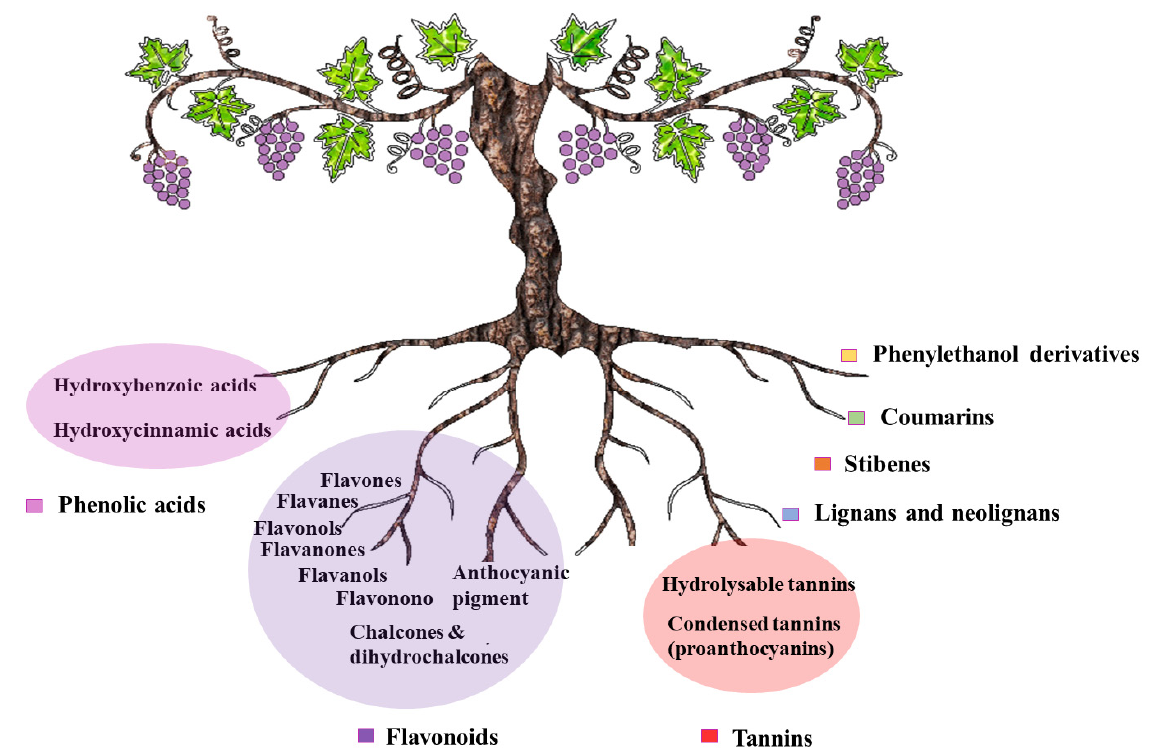
Figure 2. Schematic representation of phenolic compounds’ groups.